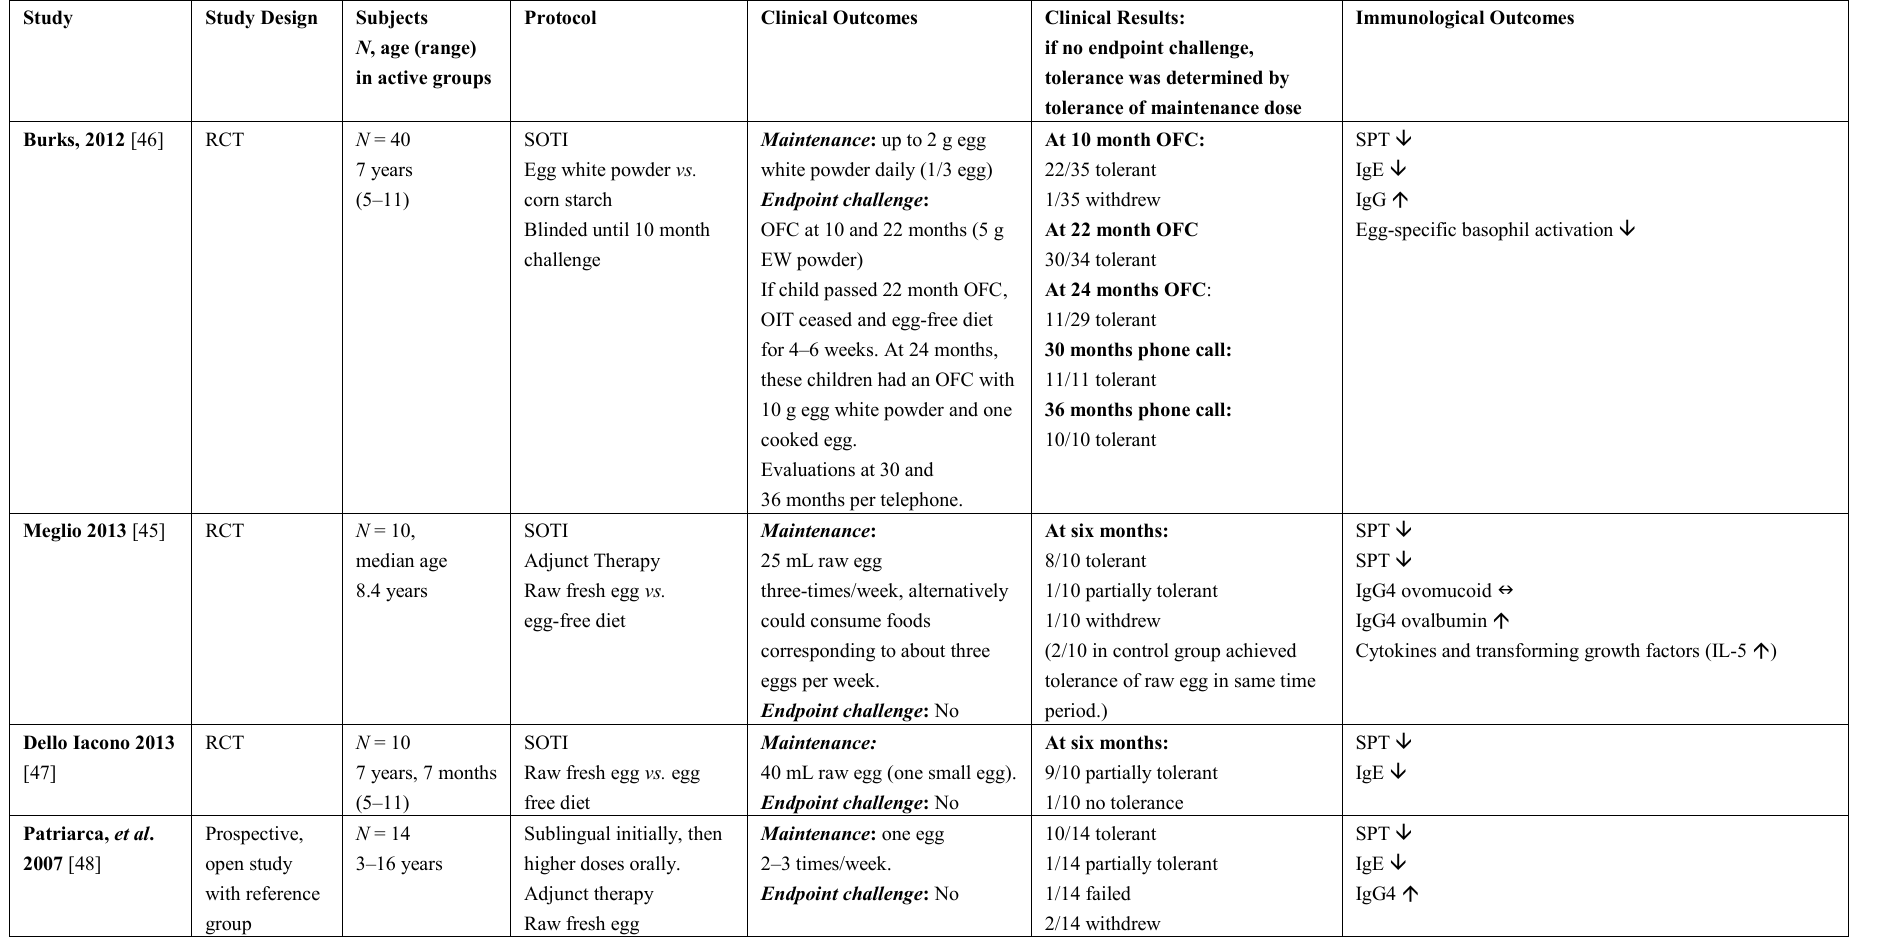
Table 1. Summary of key egg-specific oral immunotherapy